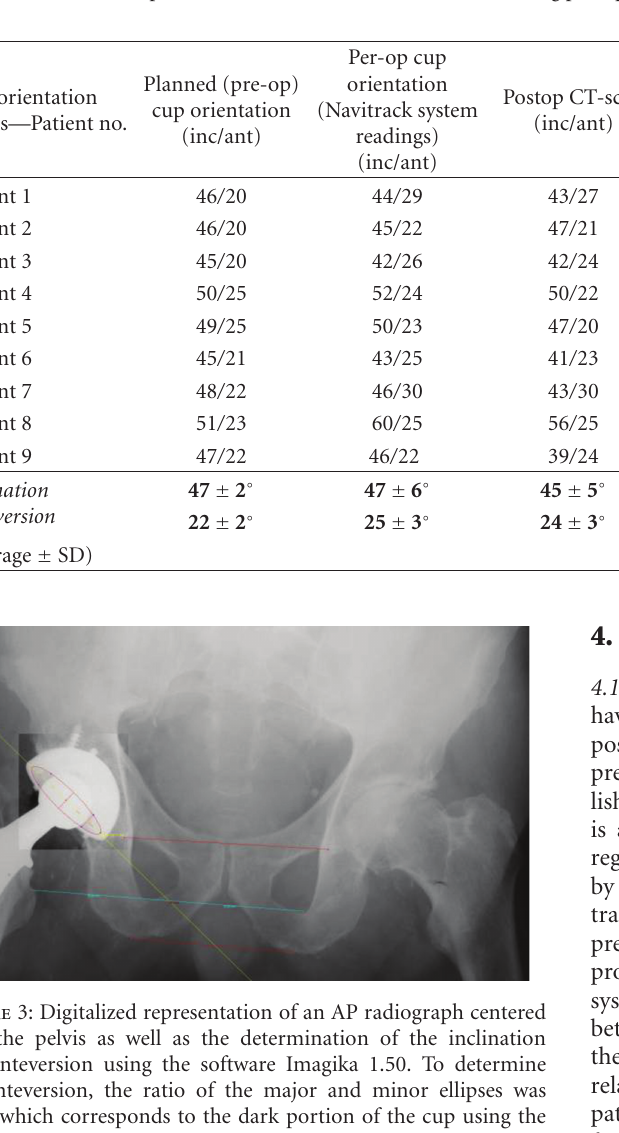
the cup were not significantly di ff erent than per-operative final reading angles ( P = .